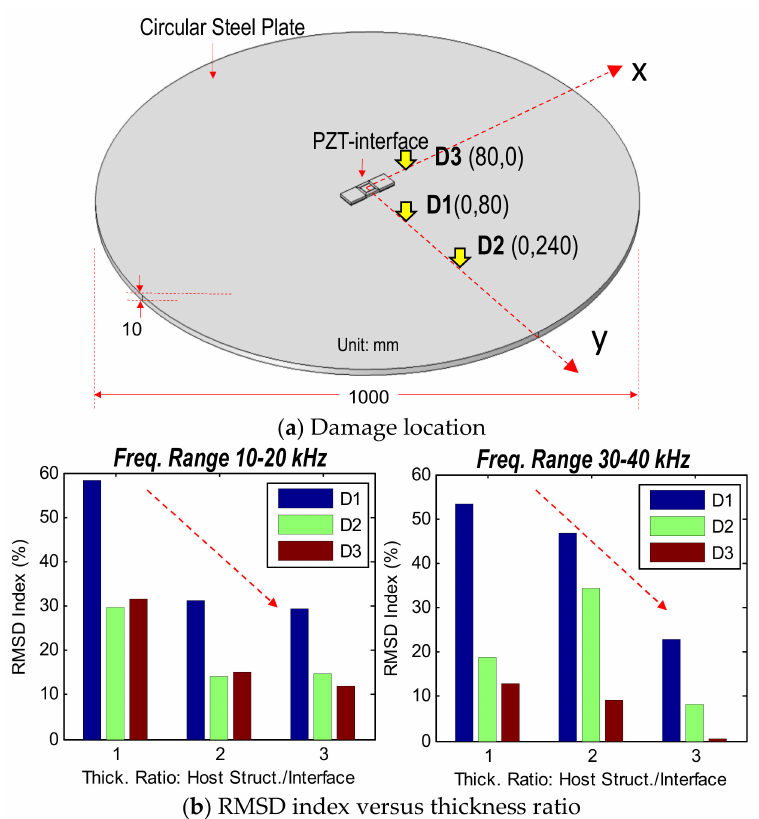
Figure 9. Damage detectability of PZT interface’s impedance signatures with respect to plate’s